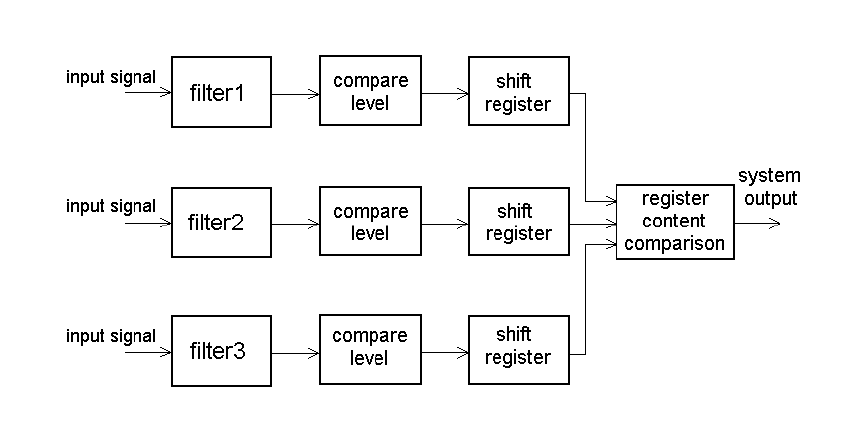
Figure 9. Block diagram of the siren detection